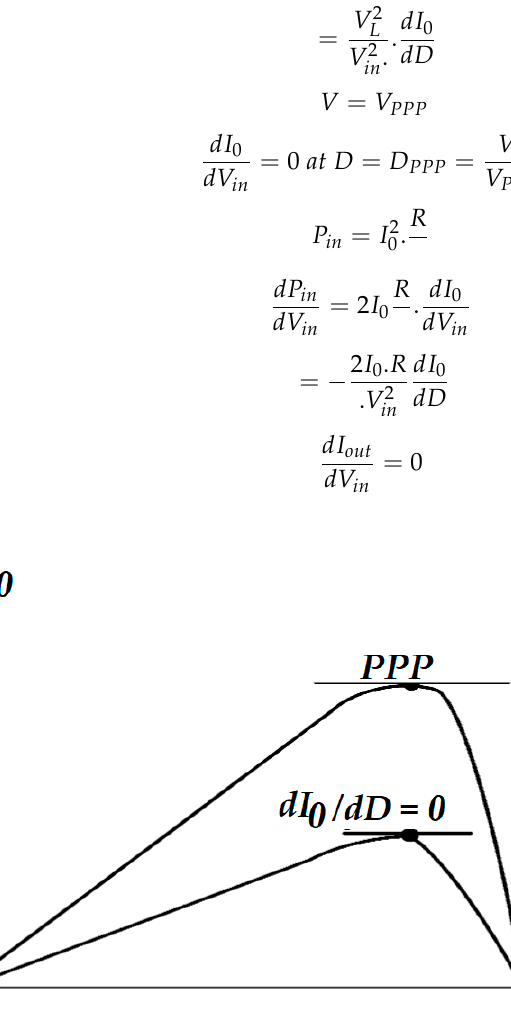
Figure 7. Input power and output current.